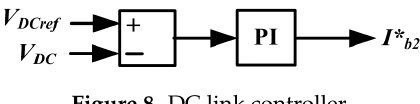
Figure 8. DC link controller.